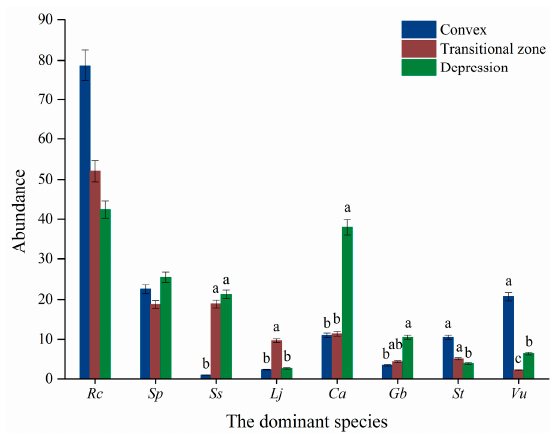
Table 4. Results of ordination based on redundancy analysis (RDA) of eight dominant species and different environmental factors, which is set in the tundra of the